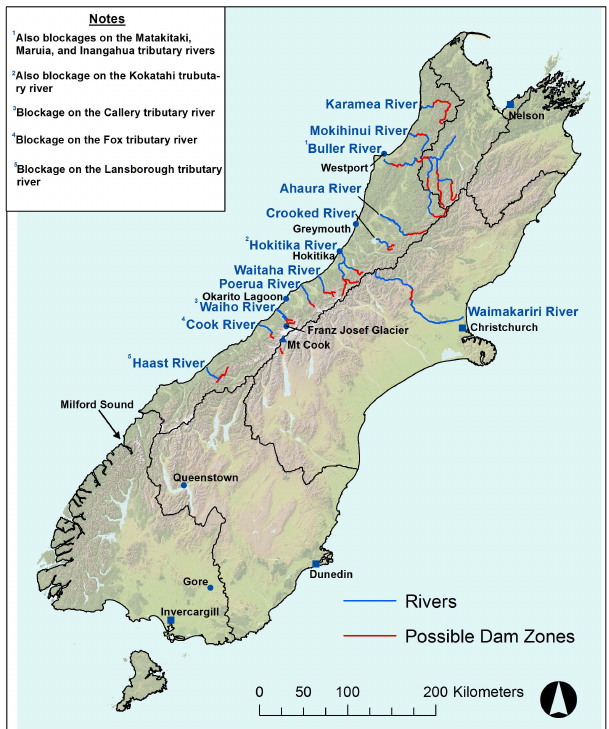
Fig. 7. South Island rivers susceptible to landslide dam